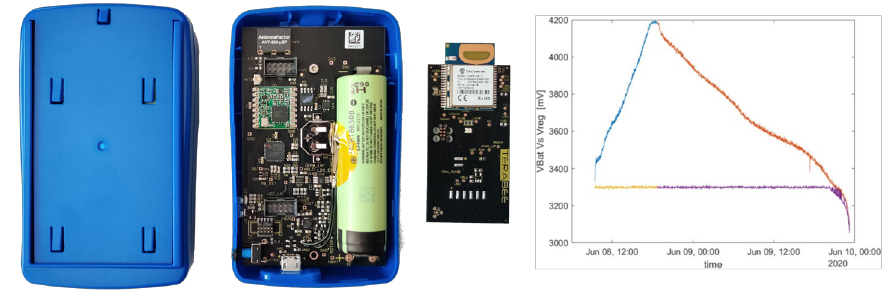
Figure 2. Receive Window